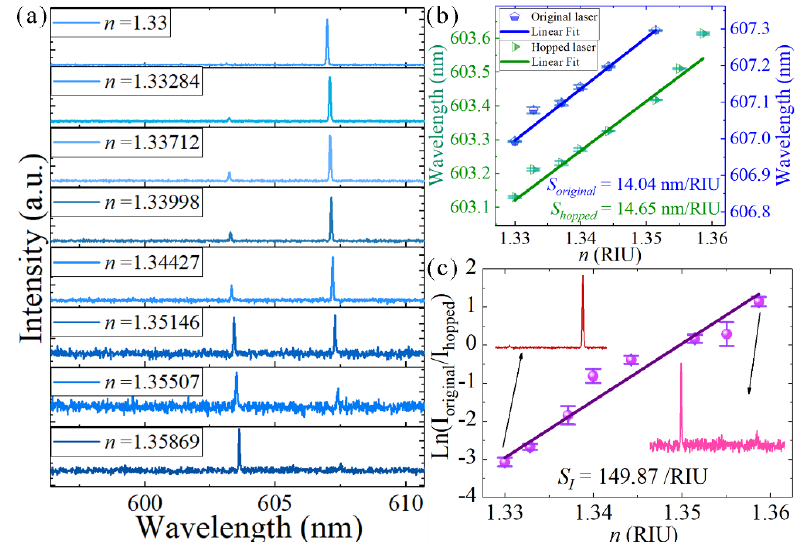
Figure 9. ( a ) Single-frequency emissions of the coupled-microdisk resonator laser. ( b ) Wavelength shifts of single-frequency lasers as a function of refractive index. ( c ) Intensity ratio [ ln ( I hopped /I original )] of the two lasing modes, as a function of refractive index. Insert: spectra at the two refractive indices values are given.